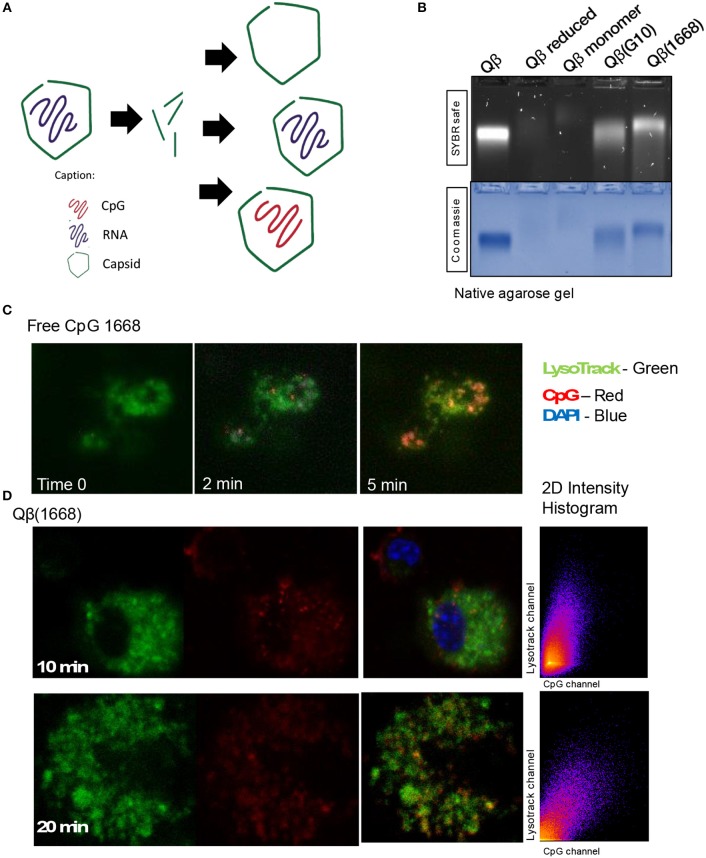
Packaging CpGs into VLPs alters endosomal trafficking of CpG. (A) Schematic representation of re-packaging of VLPs with polyanionic molecules. (B) Re-packaging of VLPs analyzed by co-localization of protein and nucleic acid in a native agarose gel stained with SYBR safe for nucleic acid (upper panel) and Coomassie for proteins (lower panel). First lane shows the migration pattern of a purified and intact VLP packaging RNA. Lane 2 and 3 with samples from the reduced and disassembled VLP. 4 and 5 shows the re-assembled VLPs with A type CpG and B type CpG. (C) Time-lapse of in vitro uptake of free CpG 1668 by BMDCs. Lysosomes is represented in green (GFP), CpG in red (Alexa Fluor 567). (D) Endosomal trafficking of B type CpG packed into Qβ VLP. BMDCs were pulsed with the VLP for 10 min (upper panel) or 20 min (bottom panel), washed and immediately fixed. First image in green shows the endosomal compartment, followed by the CpG channel. Third image contains the superposition of both channels (plus DAPI stain for the nuclei). 2D intensity histogram showing pixel co-localization of the two channels. Data is representative of 3 independent experiments.